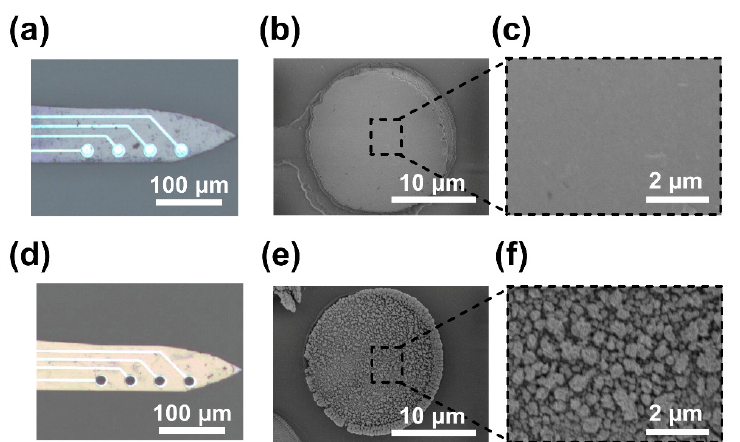
Figure 3. Surface modification of detecting sites. ( a ) Unmodified electrode. ( b ) and ( c ) The bare site observed in scanning electron microscopy (SEM) at 3.5kx and 20kx magnification, respectively. ( d ) The detecting site after modification with PtNPs. ( e ) and ( f ) The PtNP-modified site observed in SEM at 3.5kx and 20kx magnification, respectively.